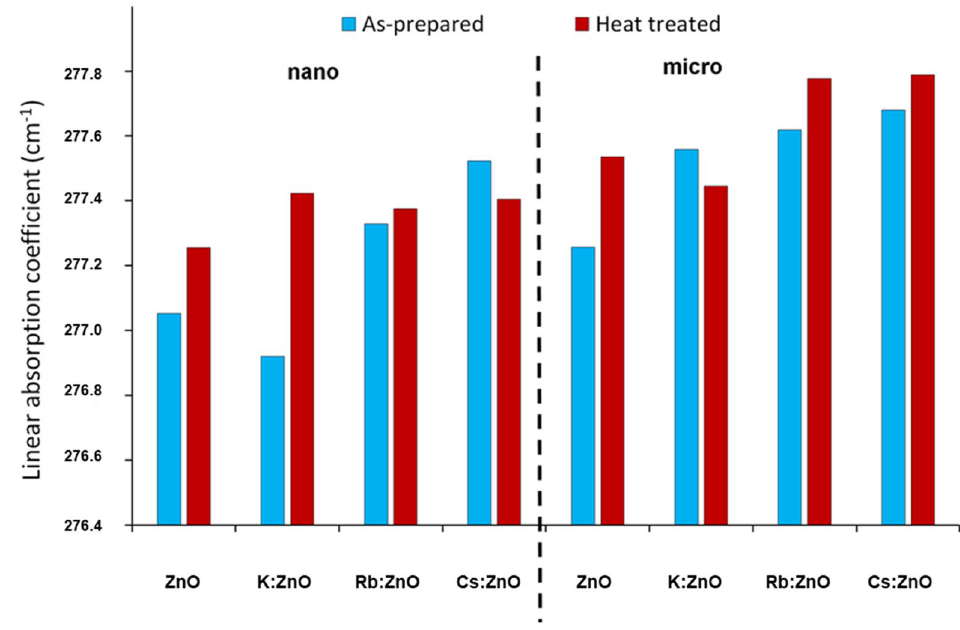
Figure 5. Linear X-ray absorption coefficient of the samples obtained from XRD